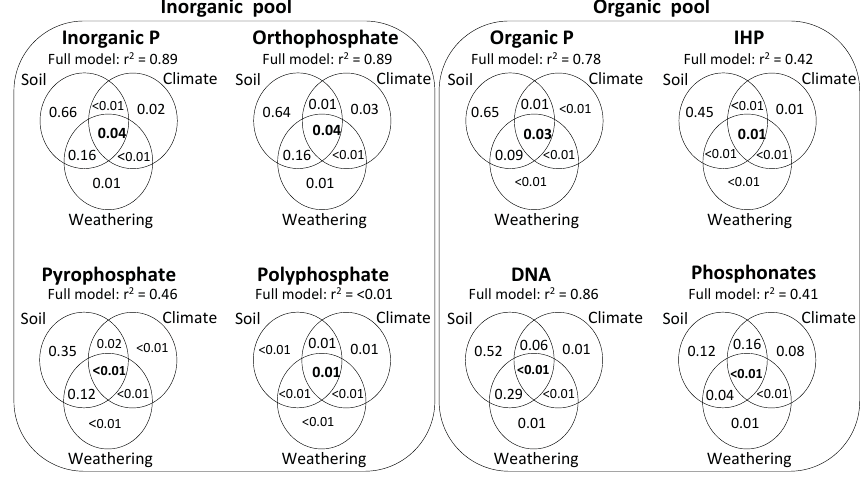
Figure 6. Variation partitioning among edaphic, climatic, and weathering stages on soil inorganic and organic P composition in NaOH-EDTA extract on natural ecosystems. Soil organic and inorganic P forms and compounds were in mgkg − 1 , and the other variables followed units described on Figs. 2 and